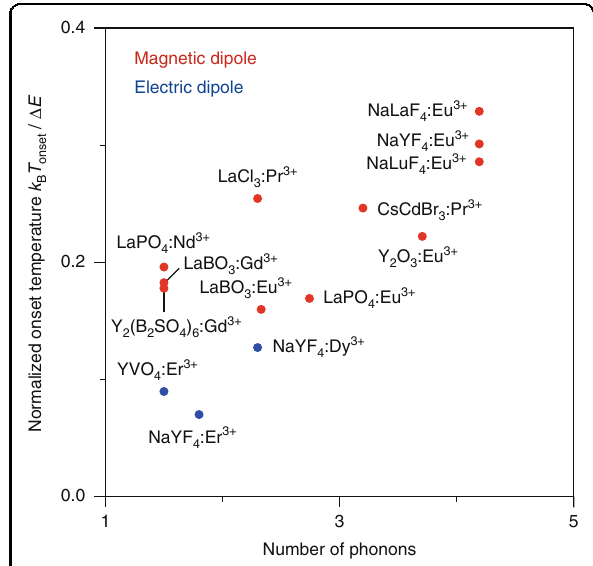
Fig. 4 Normalized onset temperatures for various Boltzmann thermometers. All onset temperatures were calculated using Eq. 6 and normalized to Δ E = k B . The results of Figs. 2 and 3 were used to calculate the onset temperatures of the Eu 3 + -based thermometers. Decay rates were extracted from literature to calculate the onset temperatures of CsCdBr 3 :Pr 3 + ( k nr 0 ð Þ ¼ 1.5 × 10 2 ms − 1 , k 1 ; r